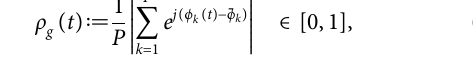
Frontiers in Robotics and AI |